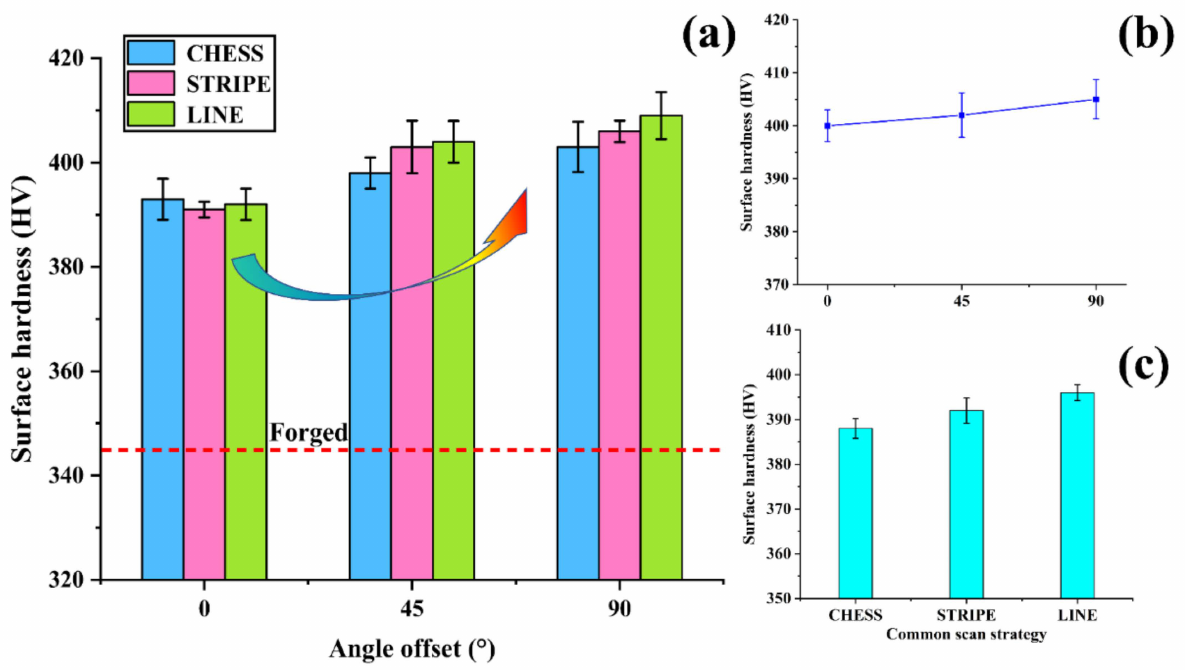
Figure 8. Surface hardness of L-PBF samples under different combinations of scanning strategies and a single scanning strategy. ( a ) Surface hardness of samples under different combinations of scanning strategies; ( b ) surface hardness of samples under angled offset scanning strategy; ( c ) surface hardness of samples under general scanning